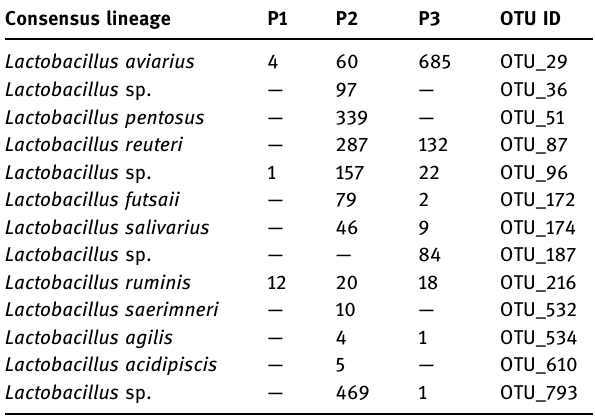
Table 3: Lactobacillus identi fi ed from the gastrointestinal ( GI ) tracts of white shrimps reared in commercial shrimp ponds Consensus lineage